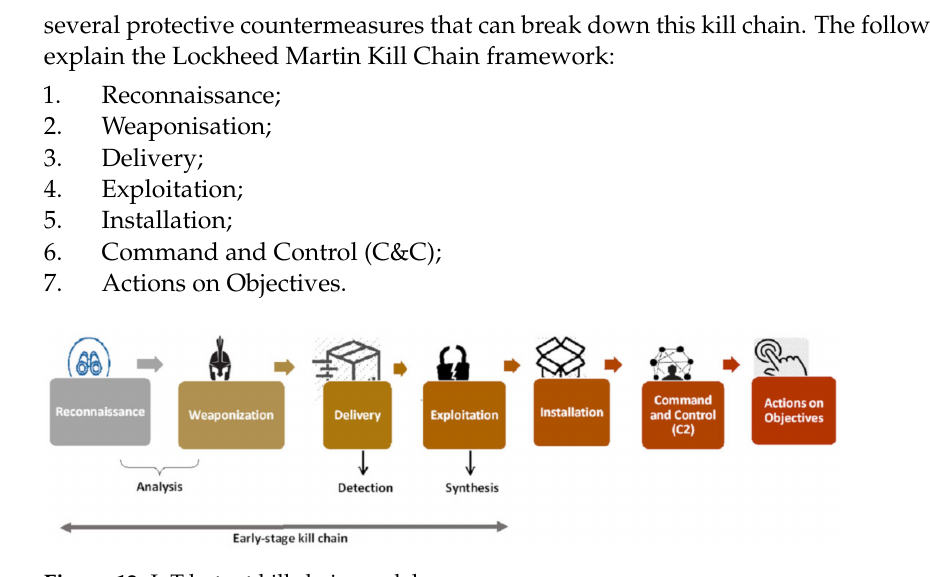
Figure 12. IoT botnet kill chain model.